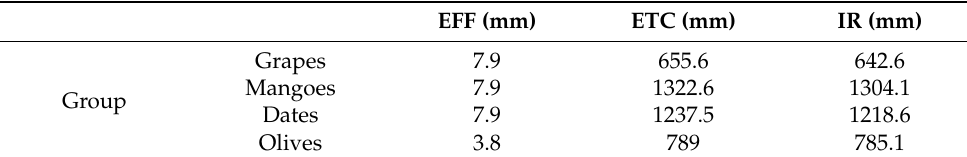
Figure 8. The results of the analysis with Cropwat 8 and the proposed scenarios.